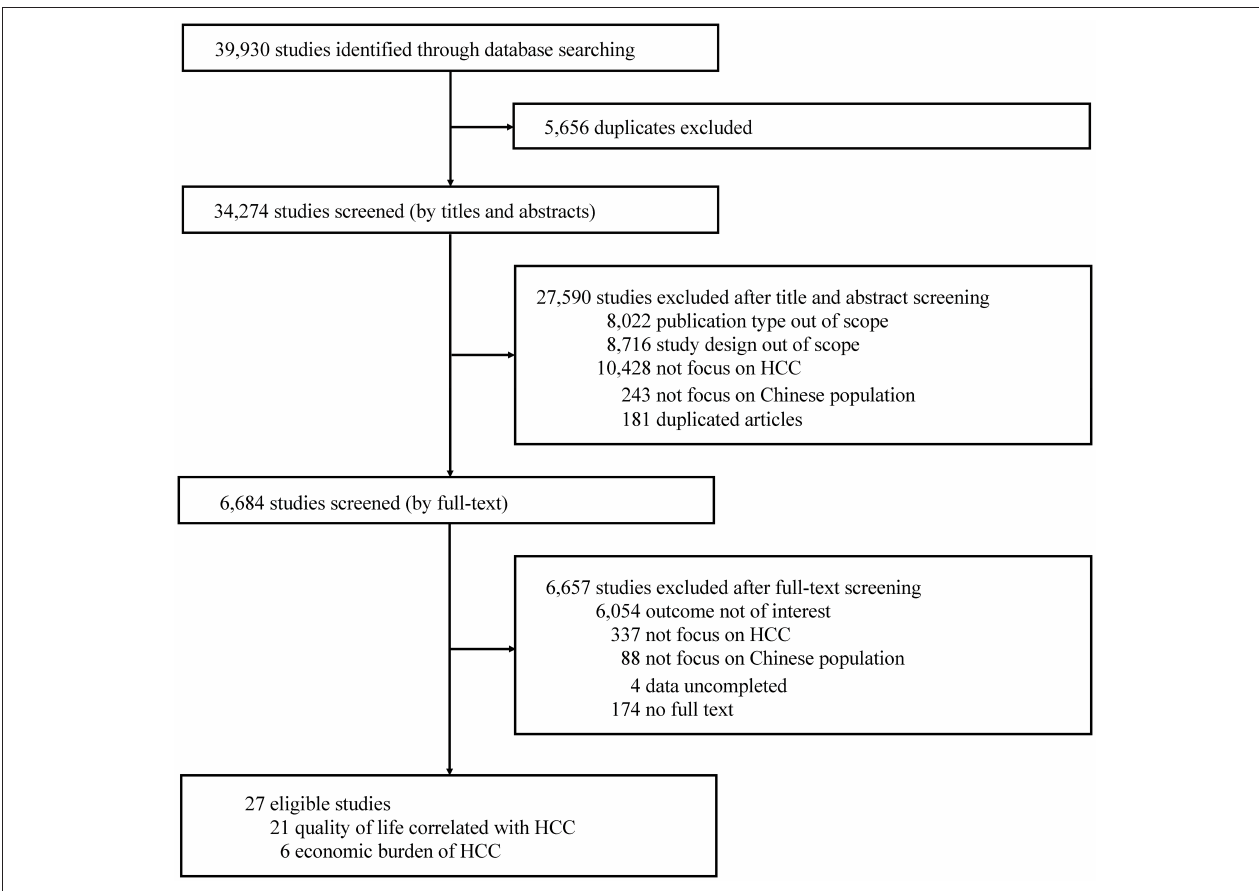
FIGURE 1 | PRISMA flowchart of study